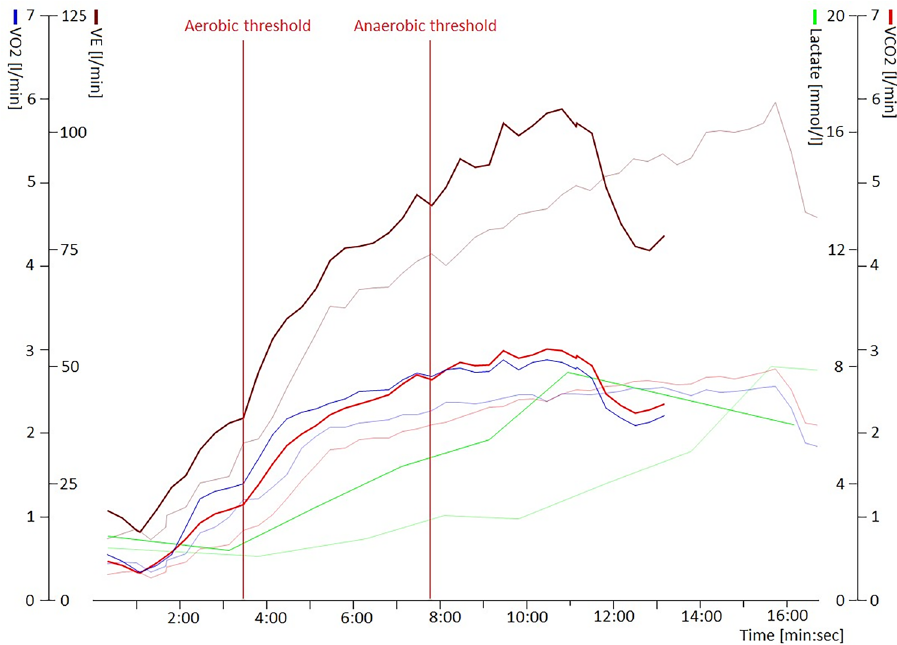
Figure 5. Decreased exercise capacity of a 19-year-old female water polo player after SARS-CoV-2 infection. On the graph, two CPET examinations are shown, between the two exanimations the follow-up time was 0.61 year. The earlier results of the examinations are shown with pale colours, the examinations after the SARS- CoV-2 are shown with sharp lines. The athlete achieved shorter running time on the same CPET protocol, with approximately the same ventilation (brown lines), slightly higher oxygen uptake (blue lines) and carbon dioxide production (red lines), worse metabolic adaptation to sports activity, which is represented by the increased lactate levels (green lines). The aerobic and anaerobic thresholds are represented with two vertical lines during the post-infection examination. In conclusion, multiple negative effects on her fitness status can be observed